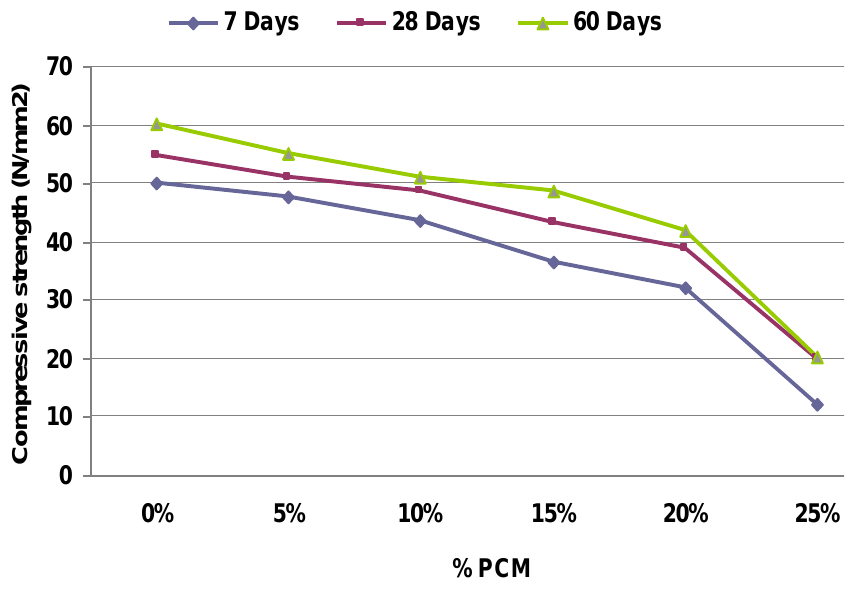
Figure 4. Relation between mechanical compressive strength and percentage of added PCM.